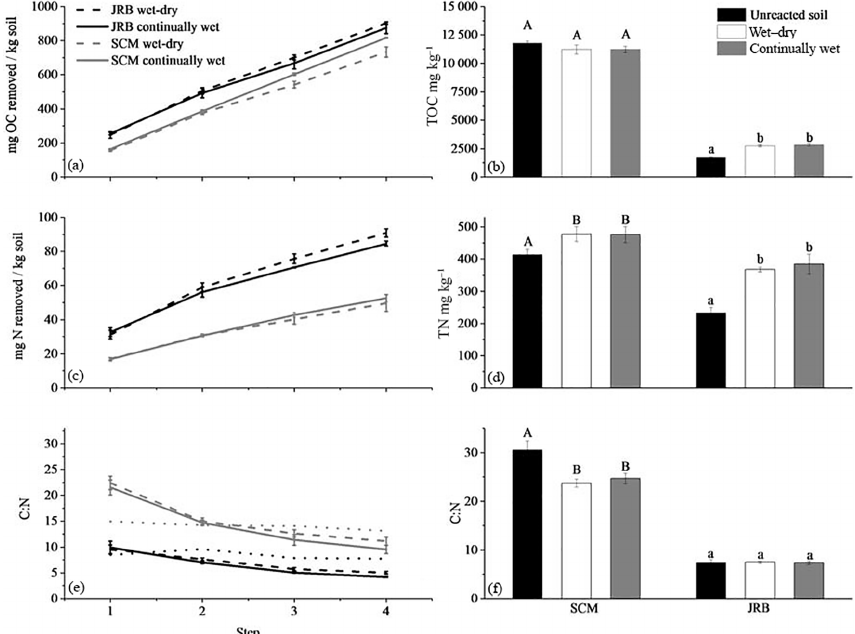
Figure 1. The organic carbon (a, b) , nitrogen (c, d) and C : N (e, f) , for equilibrated solutions (a, c, e) and solid phases after four reaction steps (b, d, f) . Values for equilibrated solution OC and N represent cumulative removal from solution per soil mass. Dashed lines in OC and N plots show continuously wet treatments, dotted lines in the C : N plot represent values of unreacted DOM solutions, error bars are the standard deviation and letters indicate significant difference (ANOVA and Tukey’s HSD p < 0.05) from unreacted